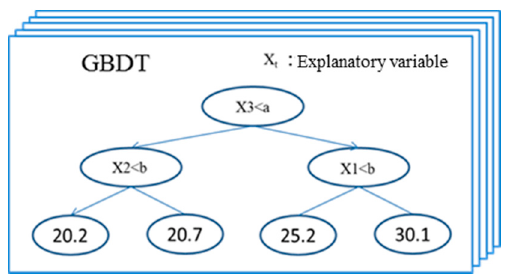
Figure 12. Image of gradient boosting decision tree (GBDT). Table 4. Explanatory